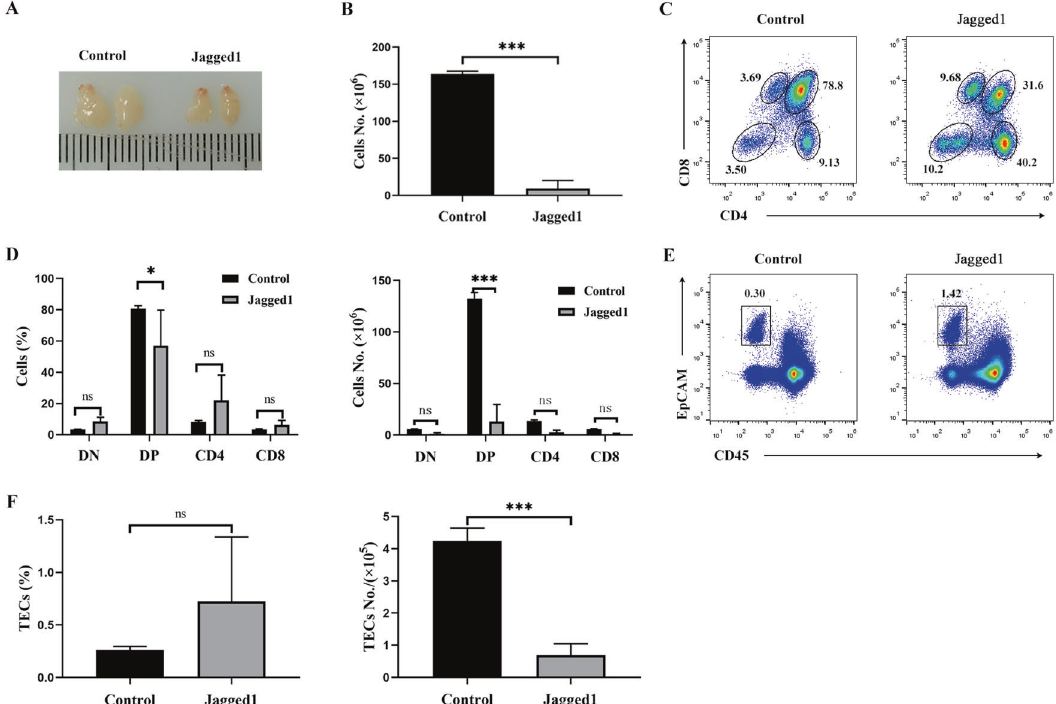
Fig. 6 Intrathymic injection of Jagged1 led to thymic atrophy. For A to F : Thymic atrophy after intrathymic injection of rmJagged1-hFc ( n = 3). The same volume of PBS was used as a control ( n = 3). A Thymus morphology and size. B Total numbers of thymocytes were calculated. C Thymocytes were stained with PE-conjugated anti-CD4 and APC-labeled anti-CD8 antibodies. The thymocyte subpopulations were analyzed by FCM. D The percentages and absolute numbers of the indicated thymocyte populations were calculated. E The cells isolated from the thymus of recipient mice were stained with Alexa Fluor 488-conjugated anti-CD45 and APC-labeled anti-EpCAM antibodies, respectively. CD45 - EpCAM + TECs were evaluated by FCM. F The percentages and absolute numbers of CD45 - EpCAM + cells were calculated. All data are from three independent experiments. Representative fi gures of these three experiments are shown. Data are represented as the mean ± SD. * P < 0.05, *** P < 0.001 compared with the control